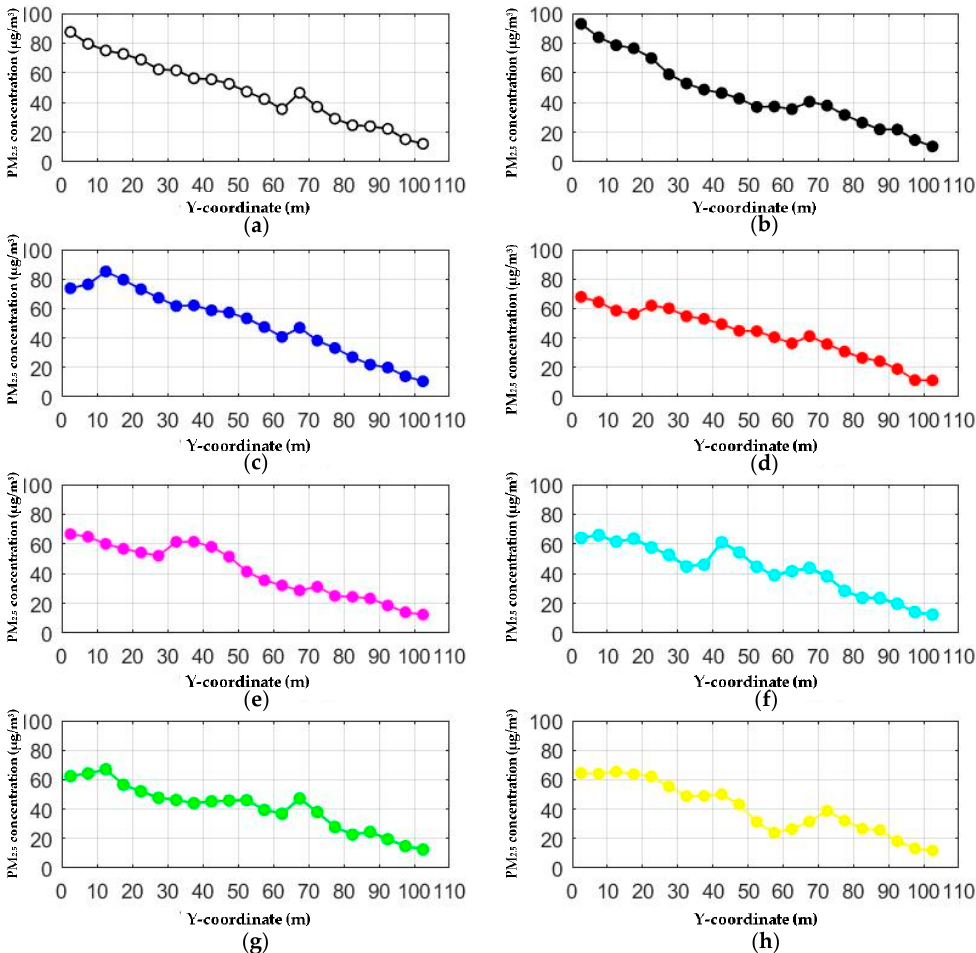
Figure 10. PM 2.5 concentration profiles for different additional entrance locations. ( a ) Basic scenario with no additional entrance; ( b ) Additional entrance at y = 0 m; ( c ) Additional entrance at y = 10 m; ( d ) Additional entrance at y = 20 m; ( e ) Additional entrance at y = 30 m; ( f ) Additional entrance at y = 40 m; ( g ) Additional entrance at y = 50 m; ( h ) Additional entrance at y = 60 m.